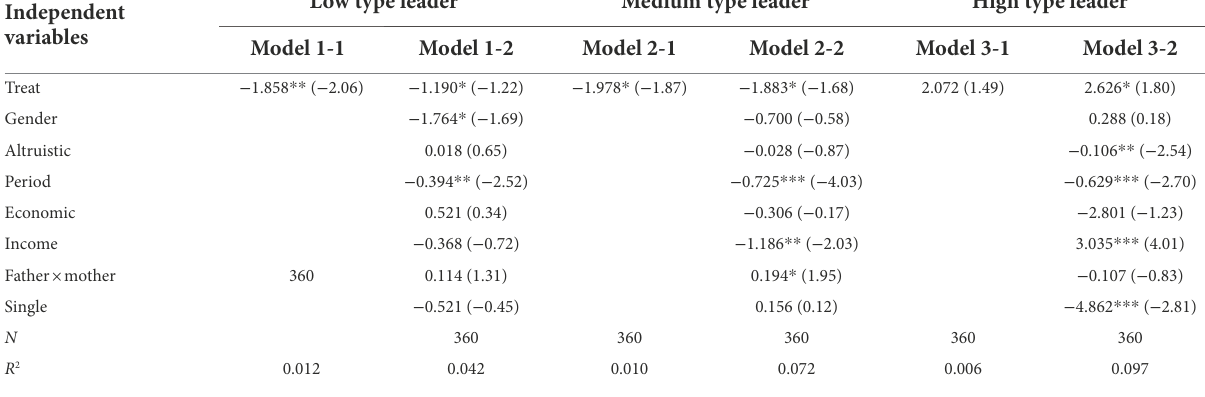
TABLE 8 Individual payoff under the influence of leader’s investment type